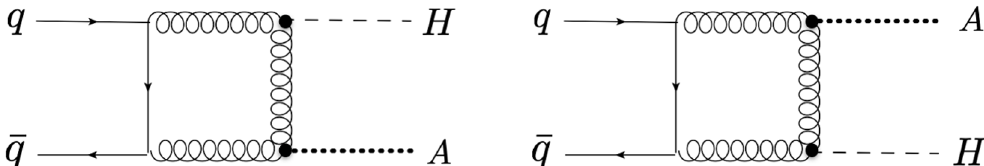
Figure 13 . Feynman diagrams contributing to the right-hand side of (5.14). The blob associated with H denotes the e(cid:11)ective Hgg vertex while the blob associated with the auxiliary pseudoscalar A results from the local operator G ~ G